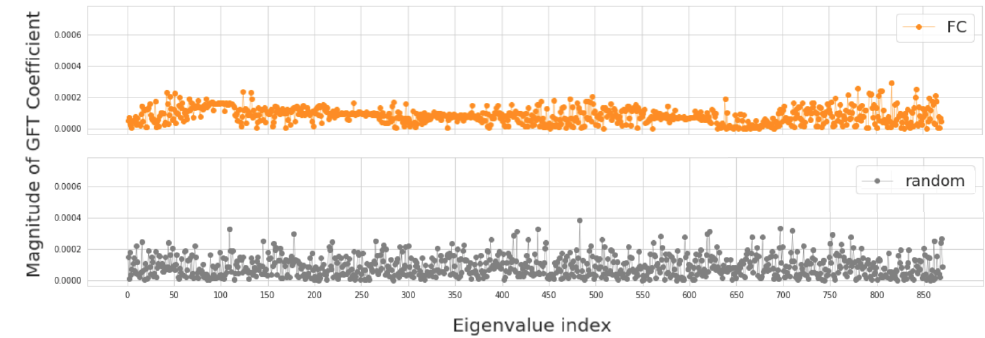
Figure 4. The magnitude of GFT coefficients for graphs which exhibit low-frequency nature. The eigenvalues are sorted in order of the increasing magnitude.